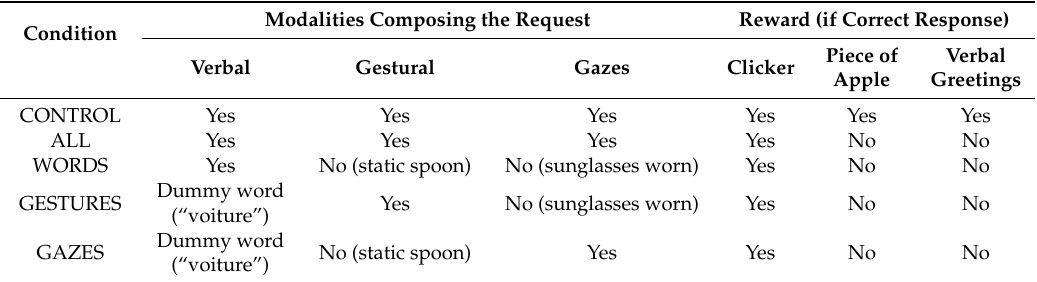
Table 1. Modality of the request and reward types used in the Control, All, Words, Gestures, and Gazes conditions of Experiment